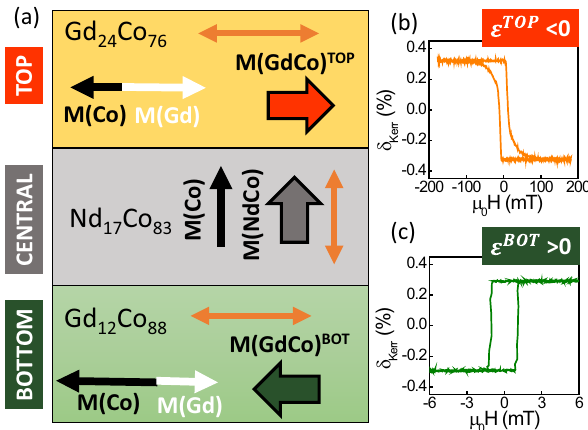
Fig. 1 Multilayer design for adjustable exchange spring. a Sketch of multilayer structure. Black/white thin arrows indicate magnetization of Co and Gd atom sublattices, M (Co) and M (Gd), respectively. Thick arrows indicate net magnetization M ð GdCo Þ . Double orange arrows indicate anisotropy easy axis. b Room temperature Transverse MOKE hysteresis loop δ K vs. fi eld (with δ K ¼ Δ R R the fractional change in sample re fl ectance 41 ) of 50 nm Gd 24 Co 76 control sample, sensitive only to Co atom sublattice. Note the negative signal at saturation in a positive fi eld, indicating the antiparallel alignment between M ð GdCo Þ TOP and m Co ð Þ TOP , i.e. ε TOP < 0. c Room temperature MOKE hysteresis loop of 50 nm Gd 12 Co 88 control sample with positive signal at positive saturation fi eld, corresponding to parallel M ð GdCo Þ BOT and m Co ð Þ BOT , i.e. ε BOT > 0. The sign of ε , which is opposite at Top/Bottom layers, will determine whether interfacial, exchange and magnetostatic interactions between NdCo and GdCo layers either cooperate or compete with each other. The exchange spring will appear at the surface with ε < 0 ; as discussed in the